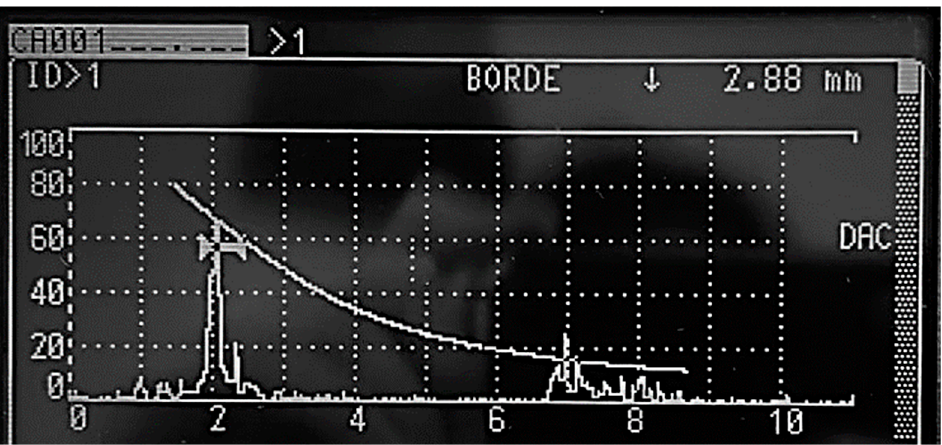
Figure 15. Ultrasound results with indication for Tool 2 trial (EPOCH 4 ultrasound system).